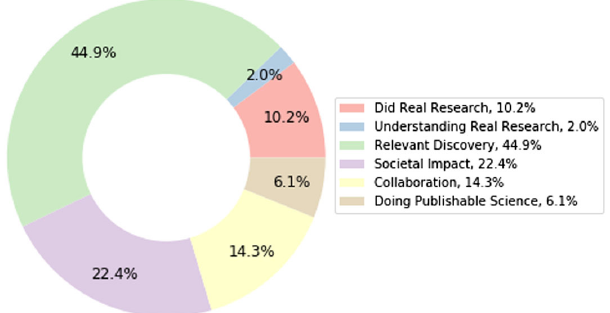
FIG. 7. Percentage of times that comparison to prior studies was co-coded with each other indirect and direct authenticity code.